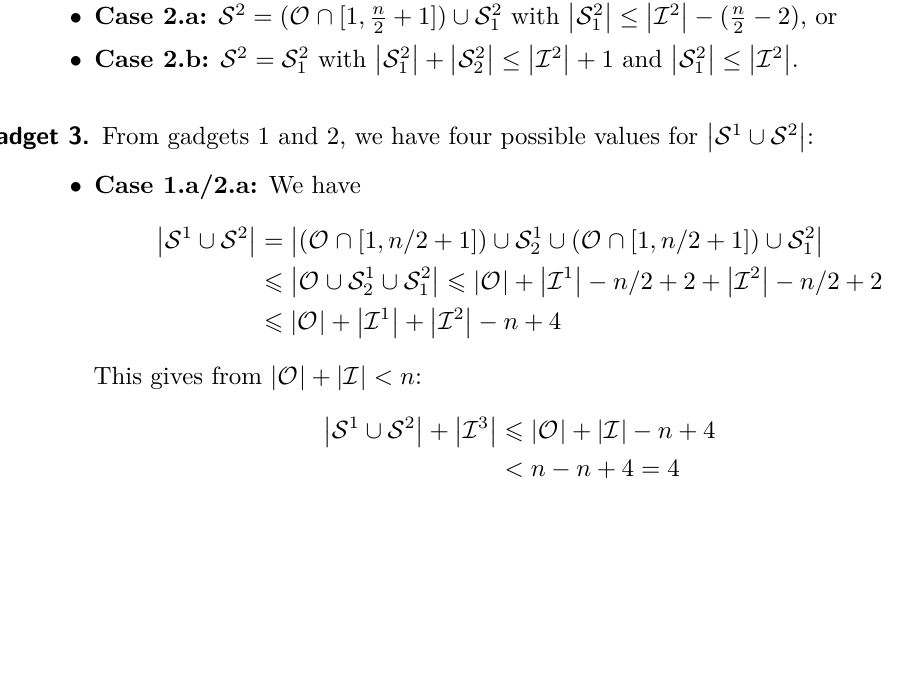
and y ( ‘ ) , for ‘ = { 1 , 2 } i i